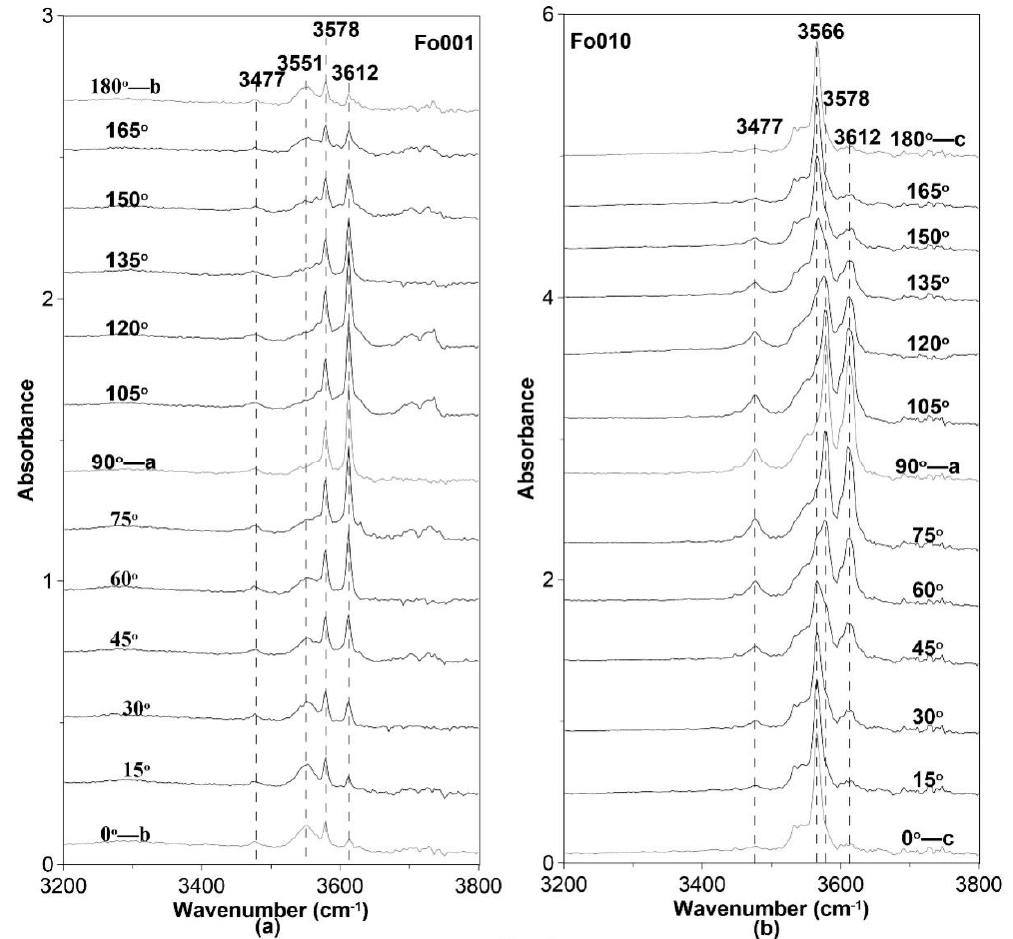
Figure 2. The polarized transmission FTIR spectra for the oriented Fo001 ( a ) and Fo010 ( b ) samples with an interval of 15° for the measurements. The angle of 90° is selected along a axis, and consequently the direction for 0° (180°) is aligned along b and c axes for the pieces of (001) and (010), respectively. − 1 The E // a spectra show strong absorption for the OH bands at 3612 and 3578 cm for Fo001 − 1 and Fo010 samples. The peaks at 3566 and 3551 cm show minimum absorptions with E // a , while maximum absorptions with E // c (Figure 3a) and E // b (Figure 3b), respectively. The polarized spectra − 1 of Fo010 show the strongest absorption for band at 3477 cm with E // a , with respect to E // c . These results are generally consistent with the earlier polarized FTIR measurements [2,4,23,36]. Hence, the polarization phenomena for the OH bands are nearly independent with the water concentration inside the crystal